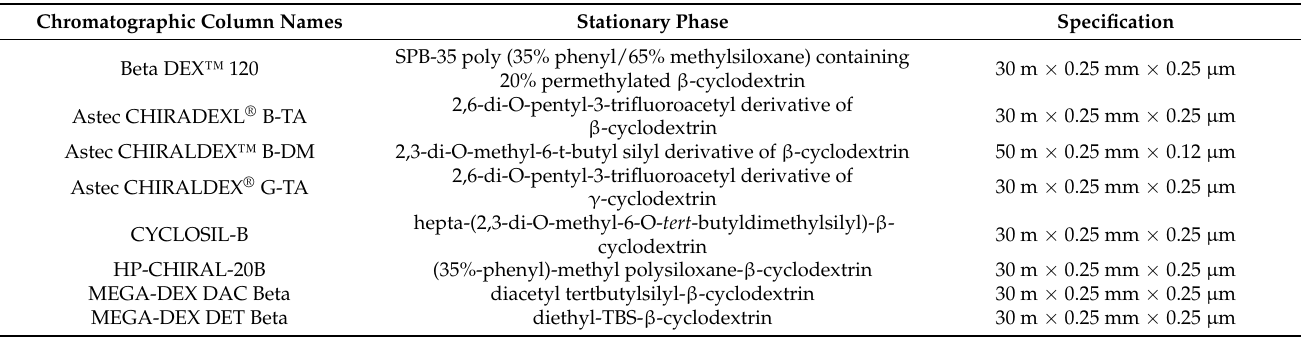
Table 2. Different column